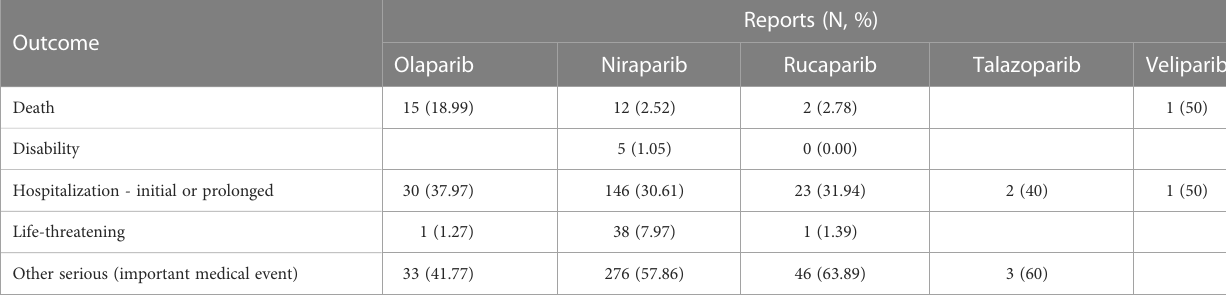
TABLE 5 Clinical outcomes of patients with haemorrhages-related adverse events.